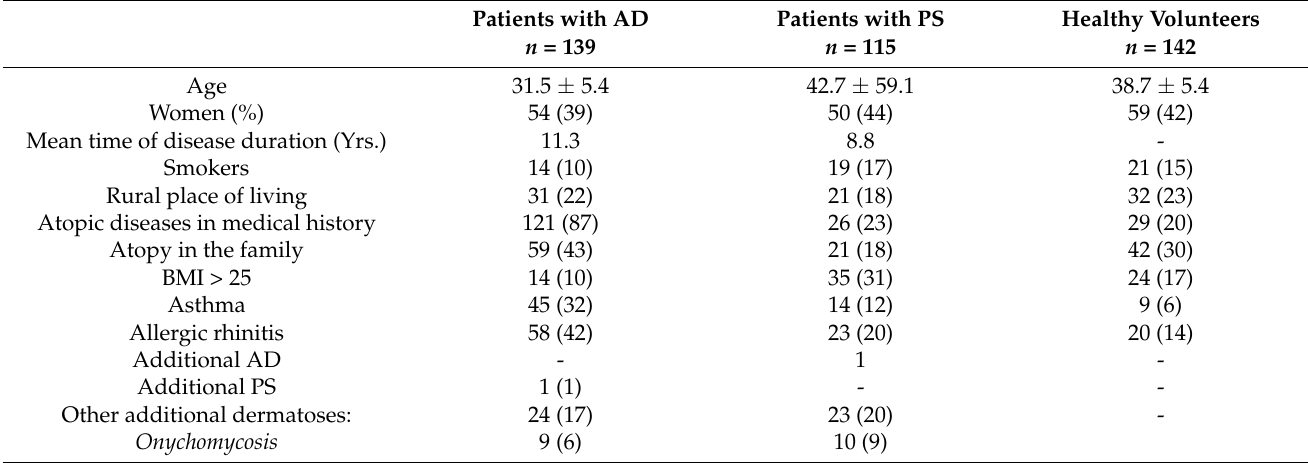
Table 1. Characteristics of the study